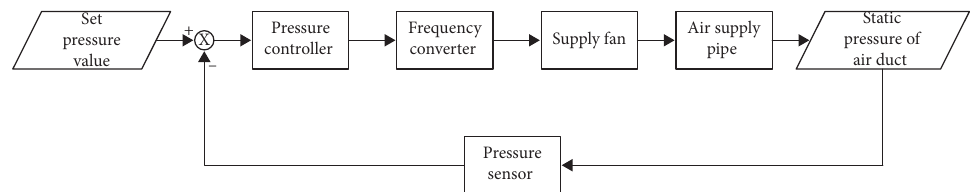
Figure 2: Diagram of the total air volume of a VAV air conditioner control system.